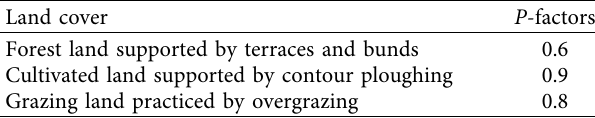
Table 4: Estimated management practices of the Kabe watershed.